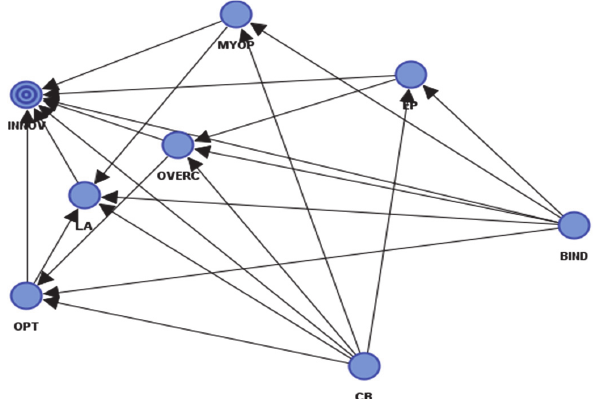
Fig. 2. Graphical model presentation: Firm’s innovation decision determinants: Bayesian Network